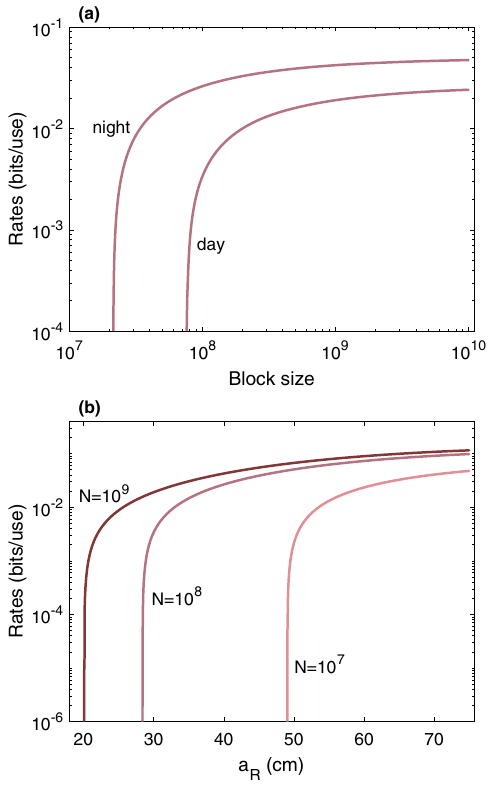
Fig. 4 Numerical results for the composable secret-key rate of a free- space CV-QKD protocol in turbulent space. The rate is plotted versus a block size and b receiver aperture size. In ( a ), an aperture size a R = 30 cm is fi xed. In ( b ), assuming night-time operation, we plot the rate for various block-size values. In both plots we assume a lossy and noisy receiver with η = 0.5, η = 0.63, and (cid:2) n ¼ 0 : 001. Distance is z = 10 km. Other eff cd ex physical parameters are set as given in Fig. 3, except (cid:2) n B which varies with a R . Protocol parameters are μ = 10, r = 0.1, d = 2 5 , frame error rate ( FER ) pe is 0.1, ε s = ε h = ε cor = 10 − 10 , w = 6.34, ε = 4.5 × 10 − 10 , and β = 0.98.